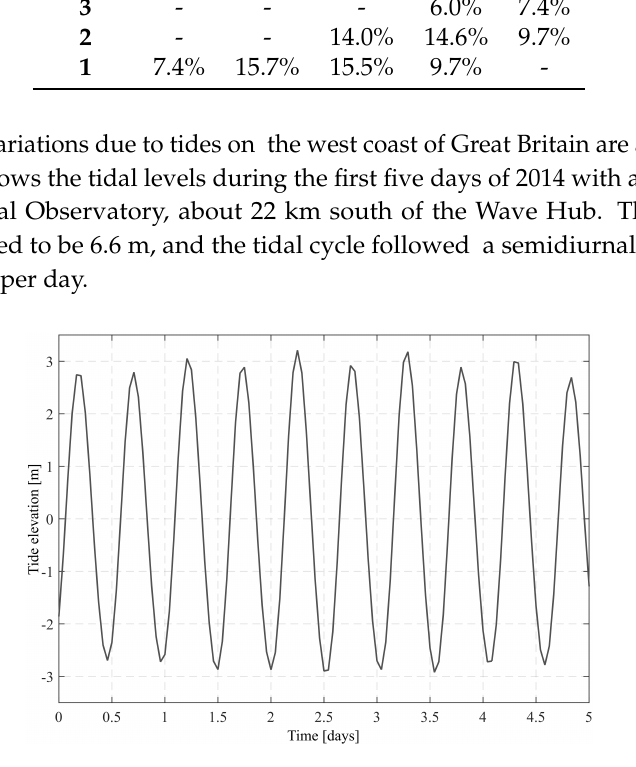
Figure 2. Sea level variation at Newlyn from 1 to 5 January 2014. Credits go to the Sea Level Data Portal hosted by the British Oceanographic Data Centre